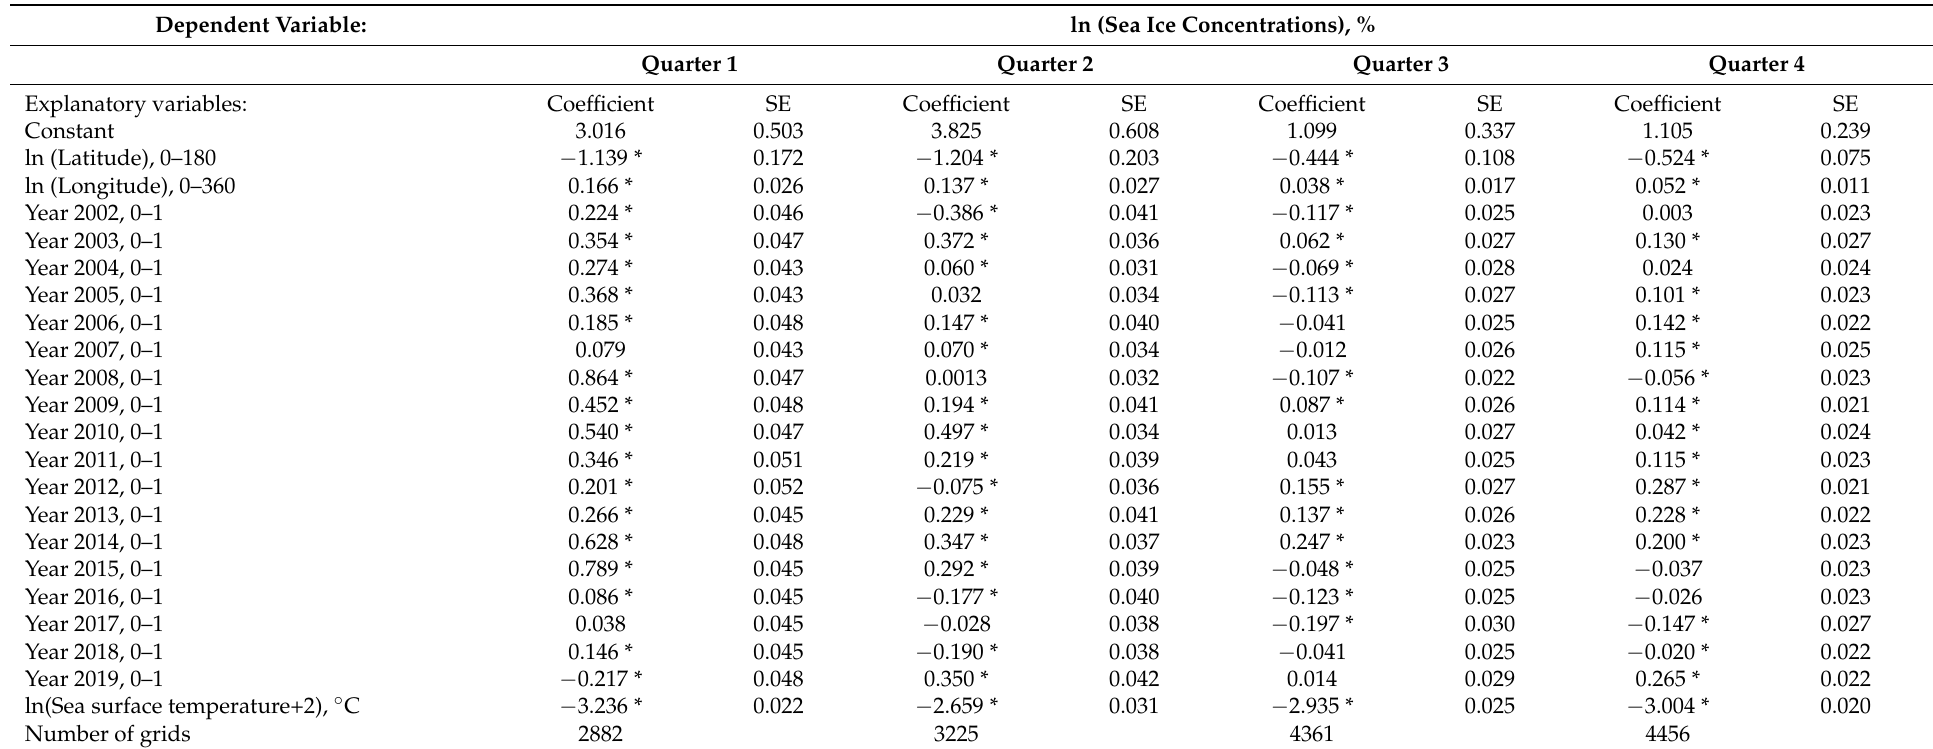
Table 6. Efficient estimates of static random effects models using quarterly data for 2000–2019 for 1 × 1 degree grids on sea ice concentrations in the Southern hemisphere explained by geodesic variables, time indicators for the years, and sea surface temperatures 1,2